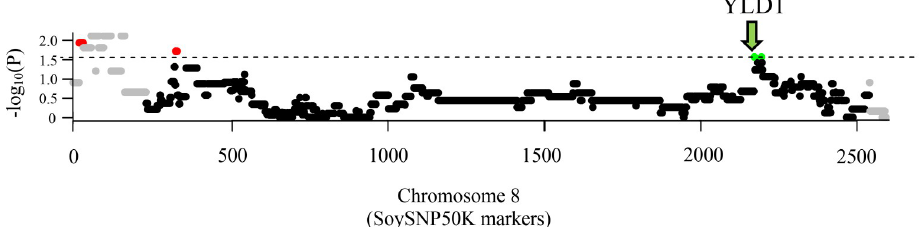
Fig 1. PI 416937 whole-genome based pedigree analysis of chromosome 8. The top section indicates genomic regions across chromosome 8 under significant positive (green) versus negative selection (red). The statistical threshold was set at a–log 10 P -value of 1.56 (Yld1). The x-axis displays marker positions from SoySNP50K Infinium BeadChips. Gray indicates a locus had less than 10 trios testing a PI 416937 allele against an alternative allele. Black indicates a locus had 10 trios or more but fell below our significance